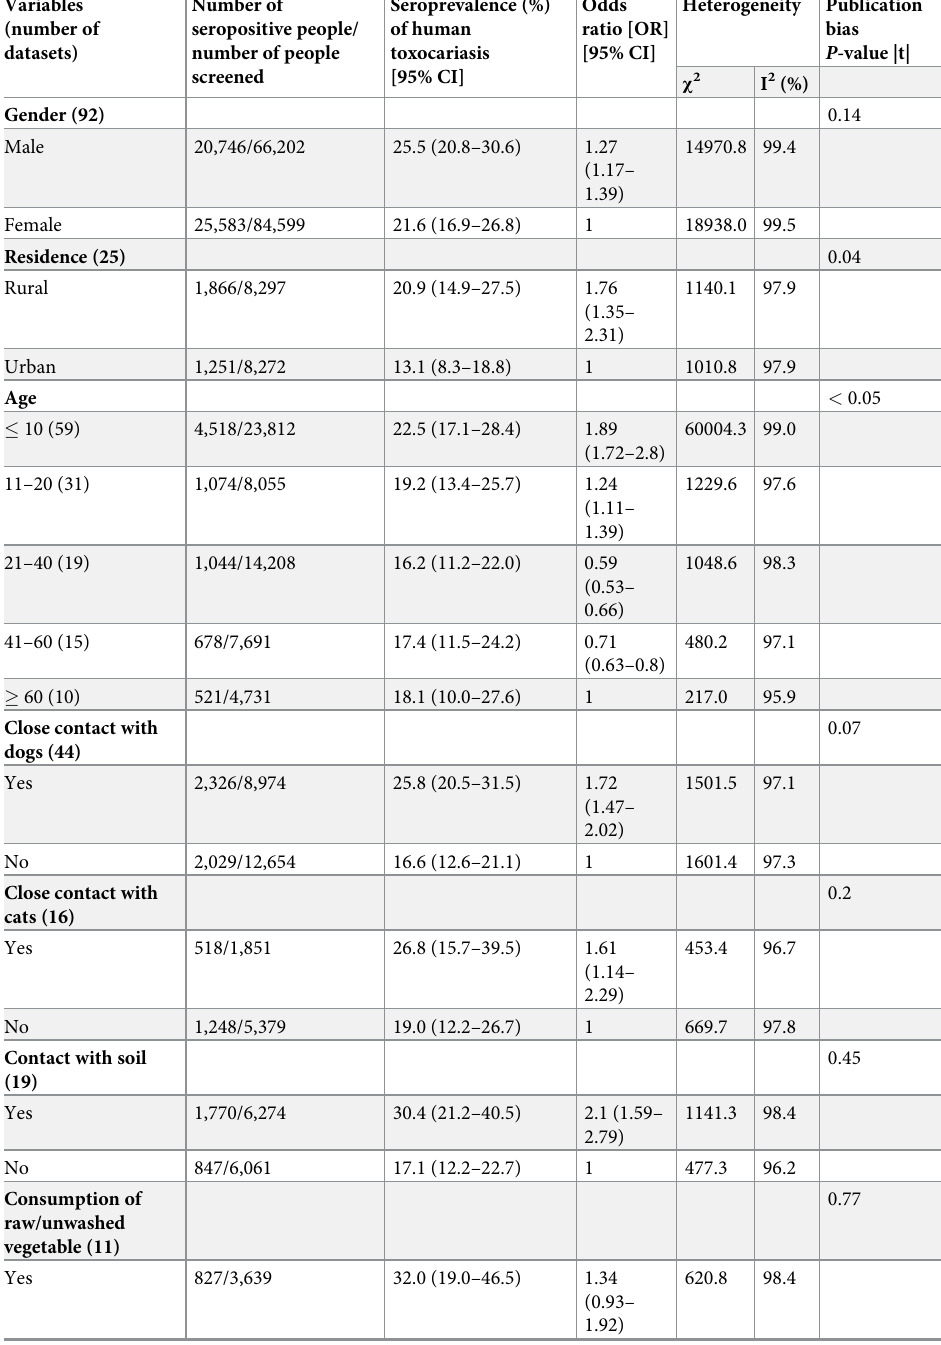
Seroprevalence (%) of